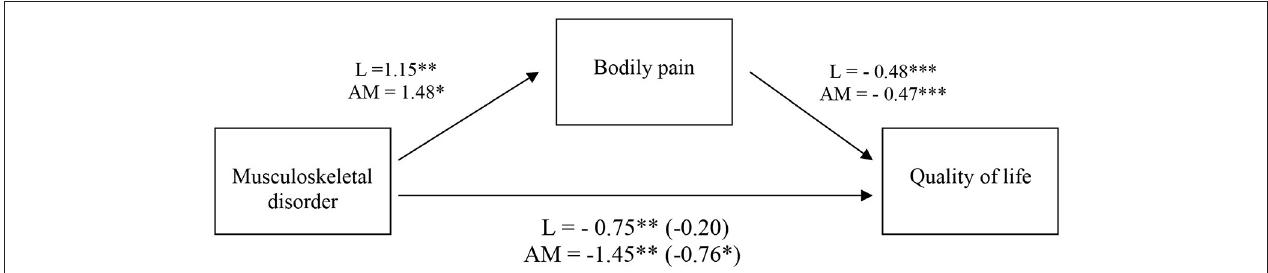
FIGURE 2 | Indirect effect of bodily pain on the relation between musculoskeletal disorders and health-related quality of life. The coefficient for musculoskeletal disorder and health-related quality of life controlling for bodily pain is shown in parenthesis. All values represent unstandardized coefficients. L, lumbar. AM, aggregated measure of musculoskeletal disorders in the cervical, dorsal, and hands and wrists areas. * p < 0.050, ** p < 0.010, *** p <